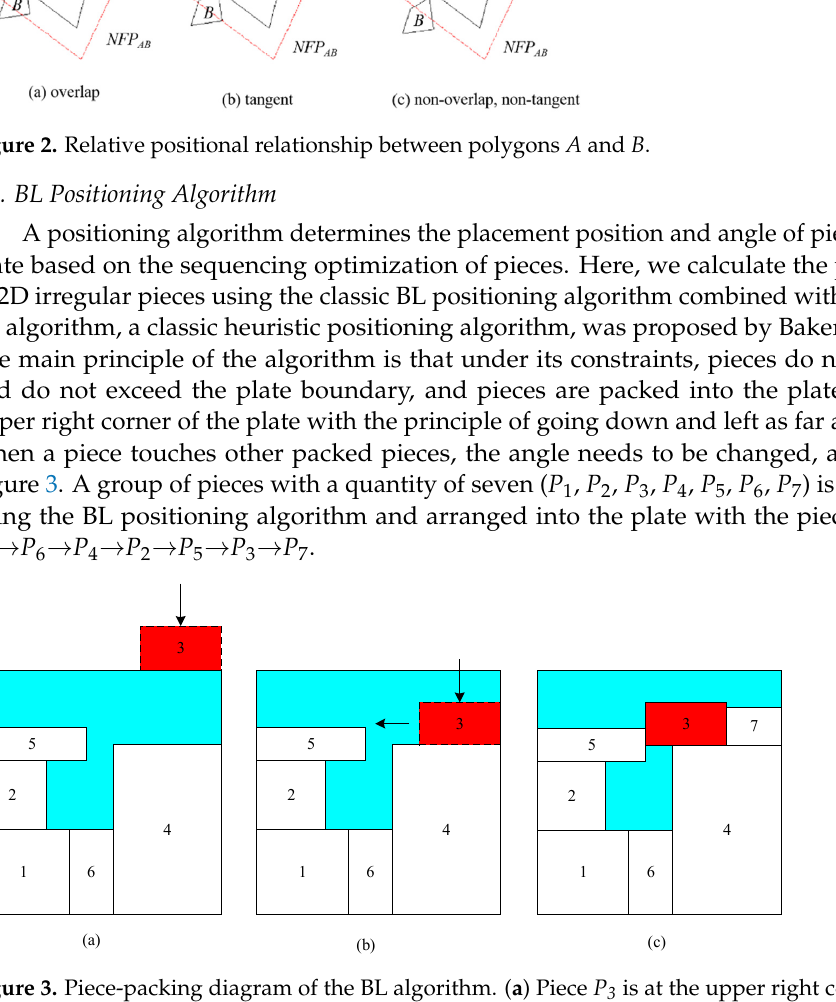
Figure 3. Piece-packing diagram of the BL algorithm. ( a ) Piece P 3 is at the upper right corner of the plate; ( b ) Piece P 3 moves downward; ( c ) Piece P 3 moves to the left.